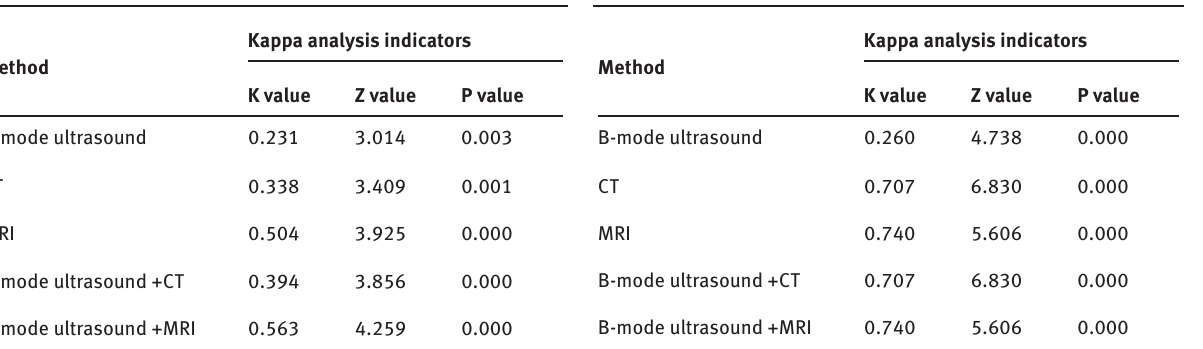
Table 5: Consistency of B-mode Ultrasound, CT and MRI